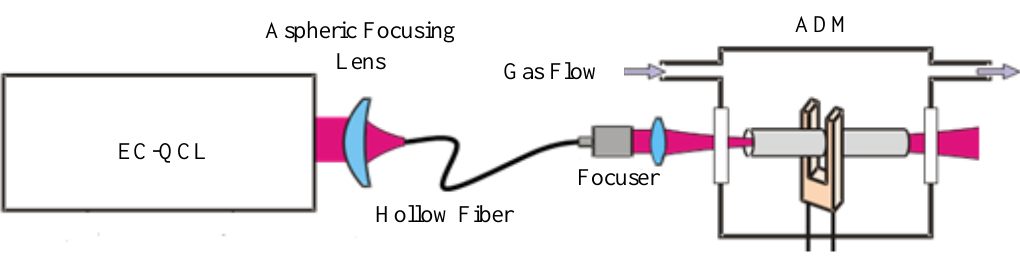
Figure 11. A fiber coupled EC-QCL based QEPAS sensor